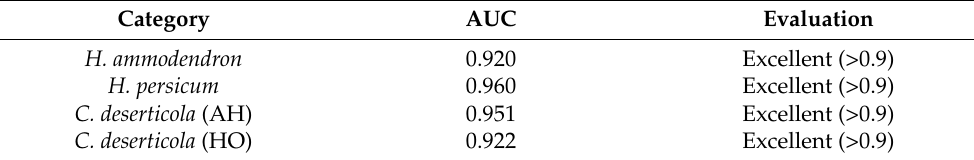
Table 2. The evaluation of models by the AUC.